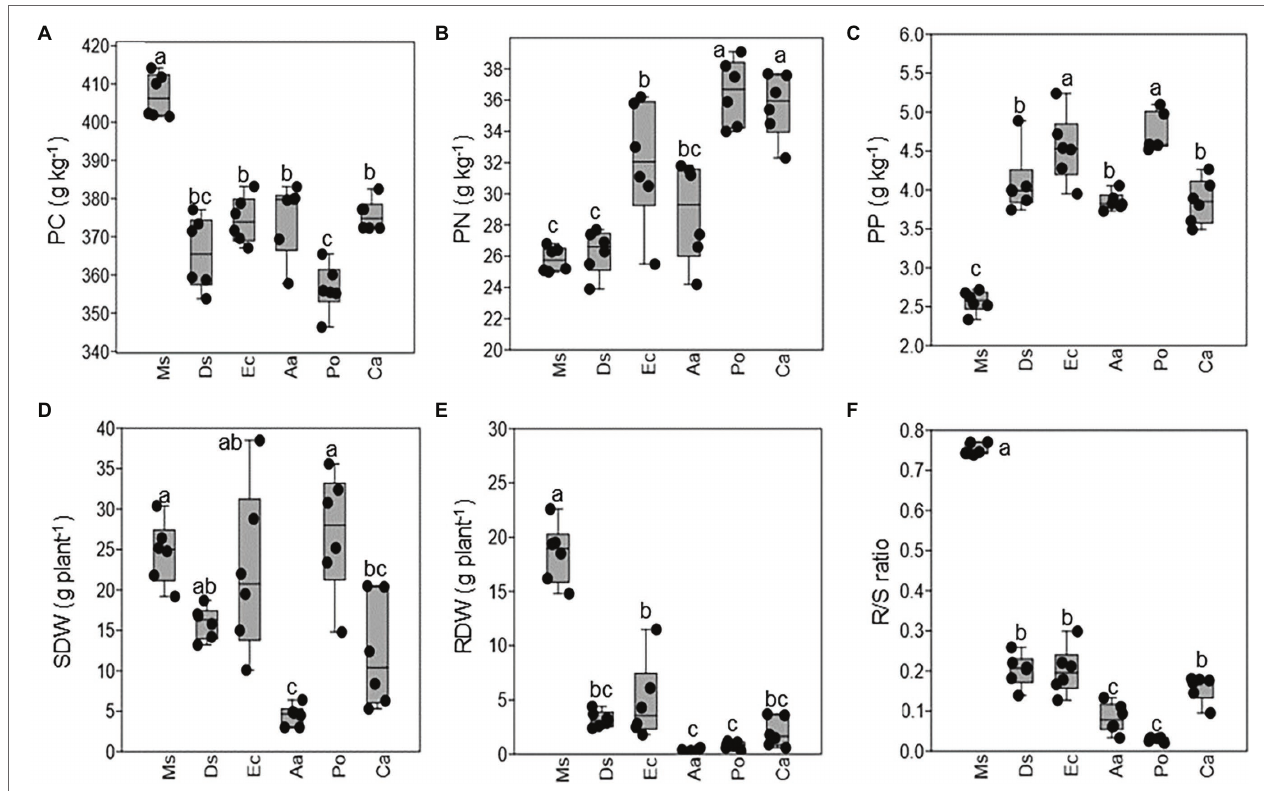
FIGURE 1 | The plant nutrients and dry weights of Medicago sativa , Digitaria sanguinalis , Echinochloa crusgalli , Acalypha australis , Portulaca oleracea , and Chenopodium album . Values followed by different letters indicate significant differences ( p < 0.05) according to Tukey’s pairwise test (PC: plant carbon; PN: plant nitrogen; PP: plant phosphorus; SDW: shoot dry weight; RDW: root dry weight; R/S ratio: root and shoot